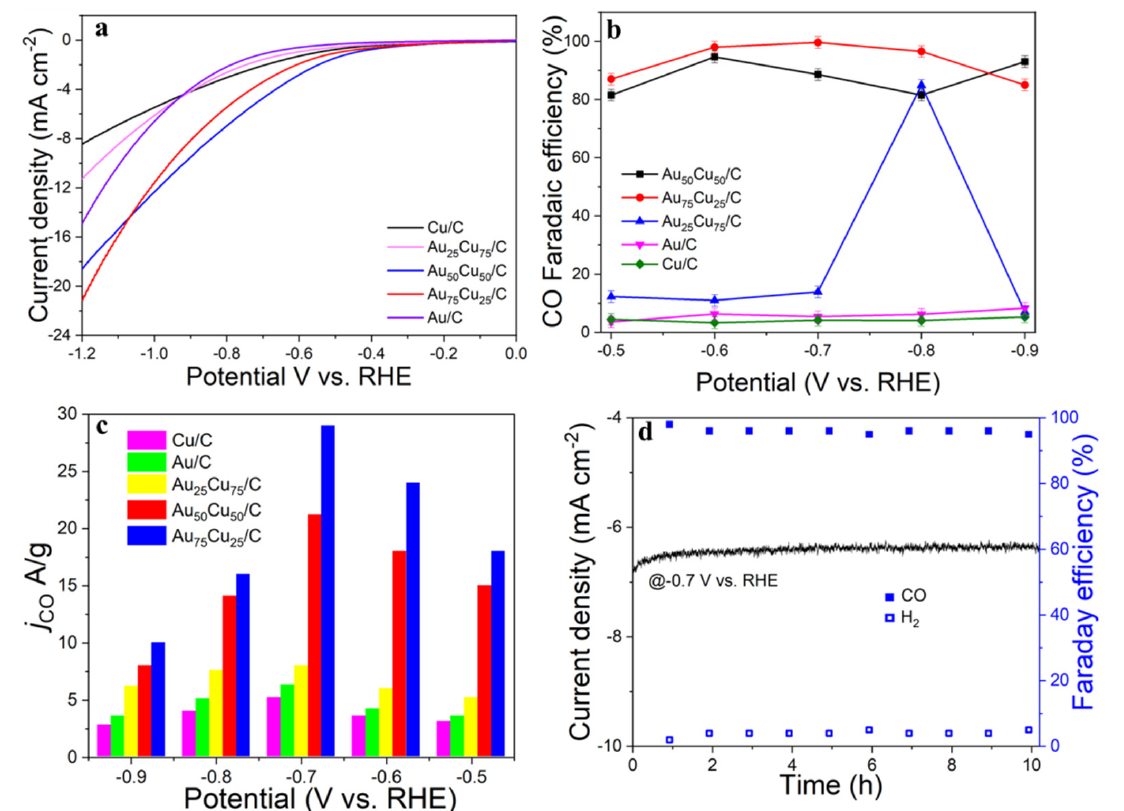
Figure 6. Performances of the Au 25 Cu 75 /C, Au 50 Cu 50 /C, Au 75 Cu 25 /C electrocatalysts for CO 2 reduction with Cu/C and Au/C as controls. ( a ) The LSV in 0.1 M KHCO 3 electrolyte saturated with CO 2 . ( b ) Faradaic efficiencies (%) at applied potential ranging from − 0.5 V to − 0.9V vs. RHE. ( c ) CO 2 reduction current density ( j CO ) with all the carbonaceous products taken into account. ( d ) Stability test and FE(%) of CO and H 2 .